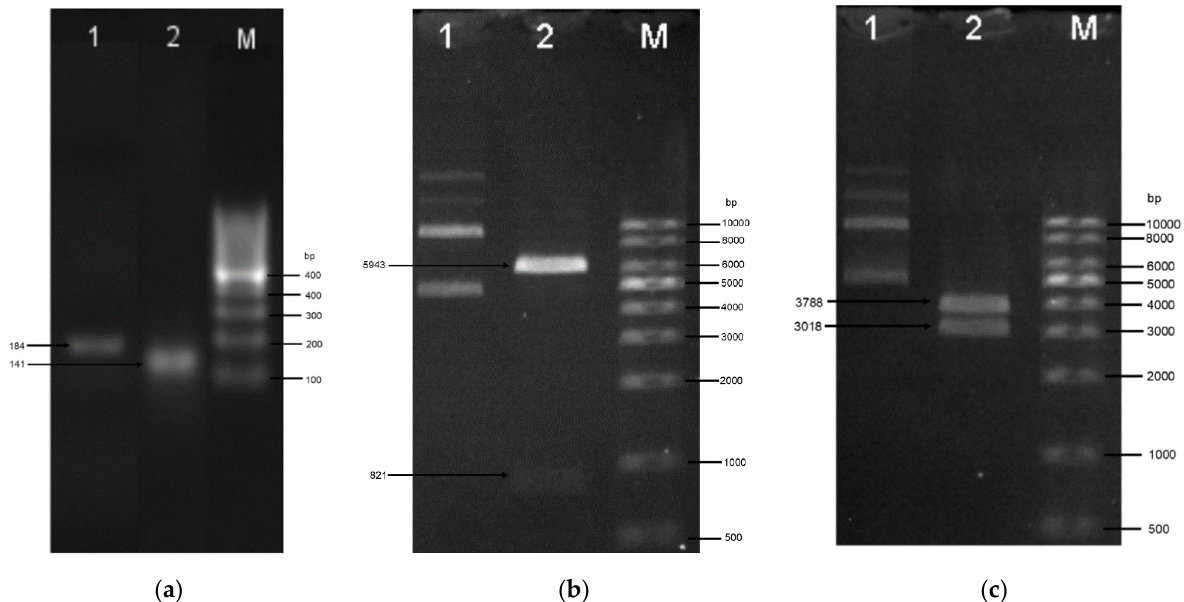
Figure 2. Agarose gel electrophoresis of ( a ) amplification of the target genes and ( b,c ) recombinant plasmids. ( a ) Target genes flanked by homologous sequences upstream and downstream of the MCS of pTXB1. L1—defensin-d2; L2—actifensin; M—100 bp ladder. ( b ) Recombinant actifensin-pTXB1 generated using MEGAWHOP cloning. L1—circularized recombinant actifensin-pTXB1; L2—recombinant plasmid digested with HindIII and BamHI; M—1 kb ladder. ( c ) Recombinant defensin-d2-pTXB1 generated using MEGAWHOP cloning. L1—circularized recombinant defensin-d2-pTXB1; L2—recombinant plasmid digested with EcoRV and BamHI; M—1 kb ladder.